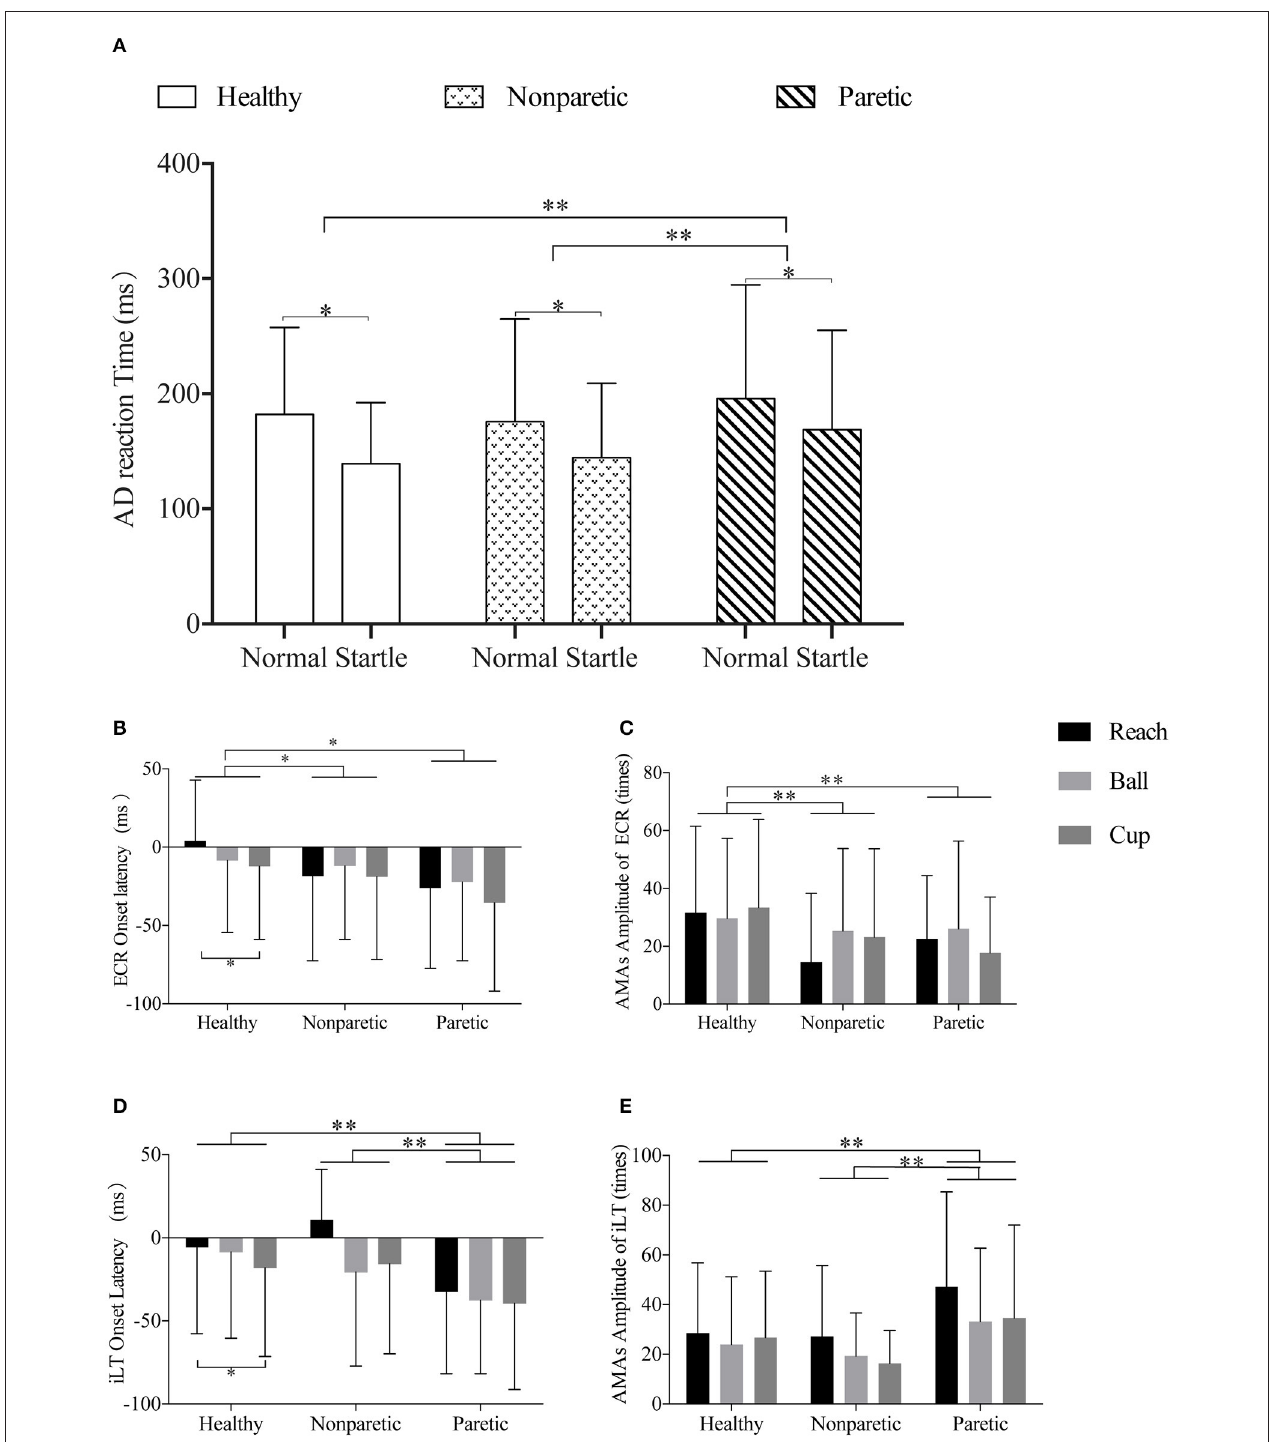
FIGURE 3 | Illustrations of the comparisons across different sides and move tasks in premotor reaction time, muscle onset latency, and amplitude of ECR and iLT. (A) Representation of the different AD reaction times of normal or startle conditions of healthy, non-paretic, and paretic sides. (B,C) Representation of the different ECR onset latency and ECR AMA amplitude of the “reach,” “ball,” and “cup” tasks in healthy, non-paretic, and paretic sides, respectively. (D,E) Representation of the different iLT onset latency and iLT AMA amplitude of the “reach,” “ball,” and “cup” tasks in healthy, non-paretic, and paretic sides, respectively. All data were presented by mean and SD. * p- value < 0.05; ** p- value <